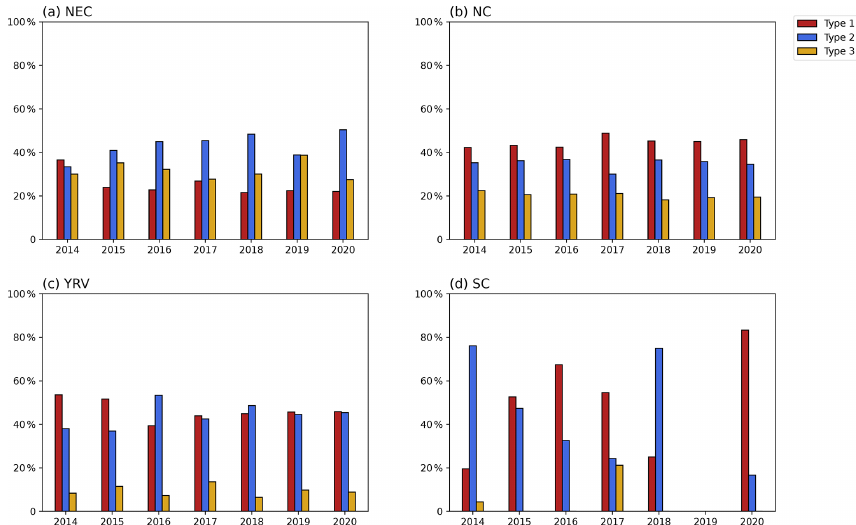
Figure 13. Annual percentage of the three types of severe HD EC in (a) NEC, (b) NC, (c) the YRV, and (d) SC.